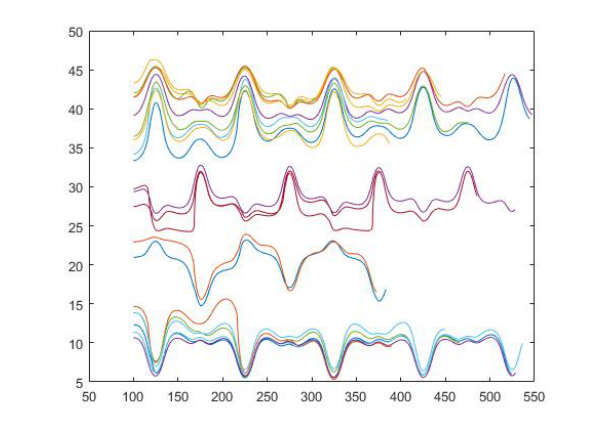
Fig. 19. Geometry A, 20 blood